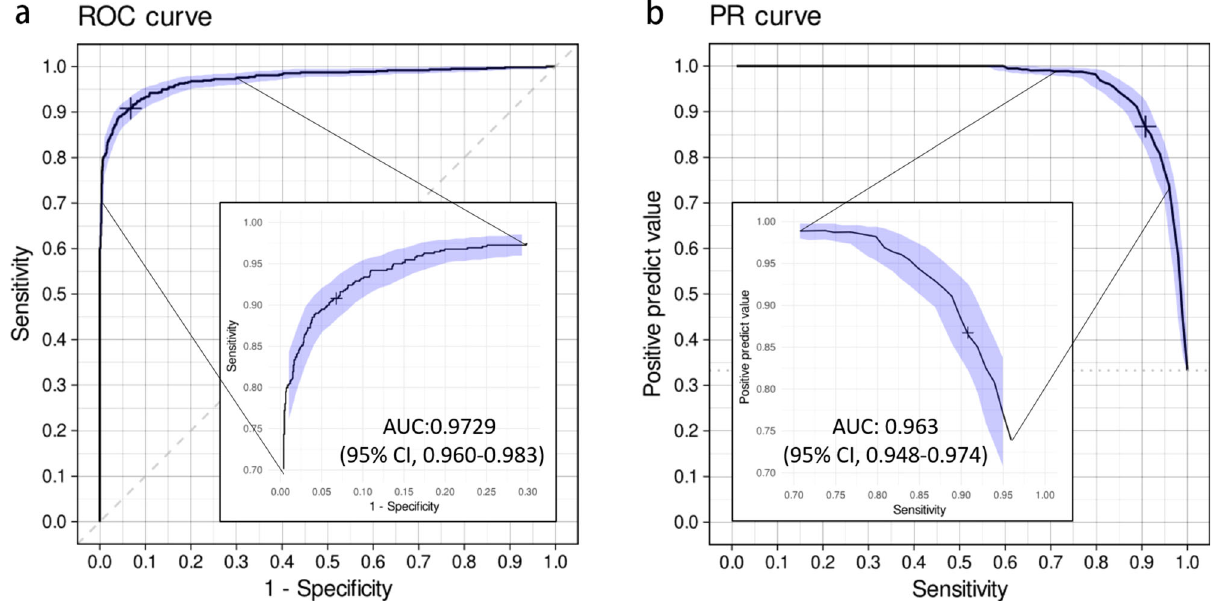
Fig. 2 The receiver operating characteristic curve and precision-recall curve of the universal trauma fi nding detection algorithm. a The receiver operating characteristic (ROC) curve of the performance of PelviXNet in the clinical scenario and the cross mark represents the performance on the probability cutoff value. b The precision-recall (PR) curve of the performance of PelviXNet and the cross mark represents the performance on the probability cutoff value. The 95% con fi dence intervals (CIs) of the ROC and PR curves were estimated using bootstrapping with 2000 replicates, which was indicated as the purple area in the